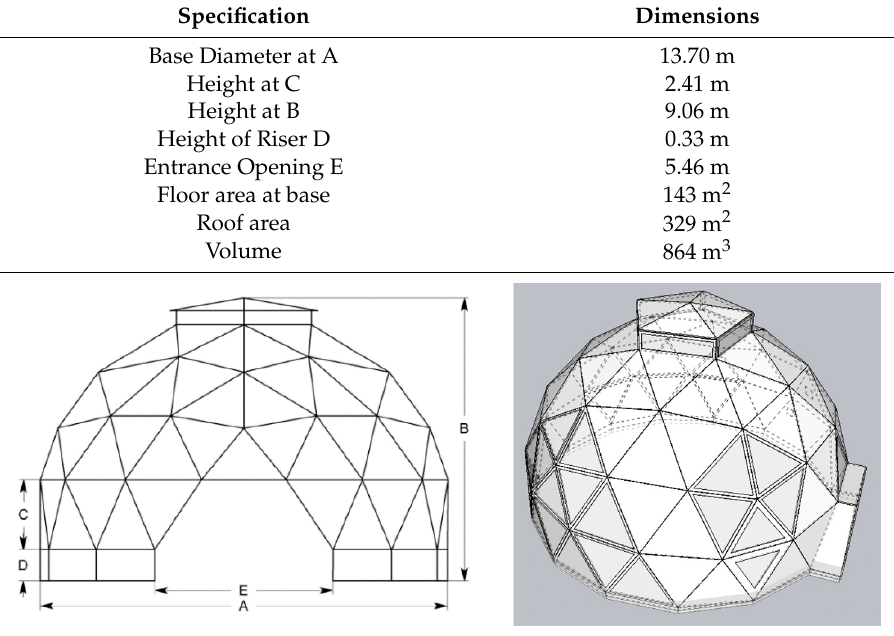
Figure 4. ( a ) Meshed model ( b ) Computational flow domain. Table 1. The specification of the applied 3v 5/9 icosahedron dome in this study. Specification